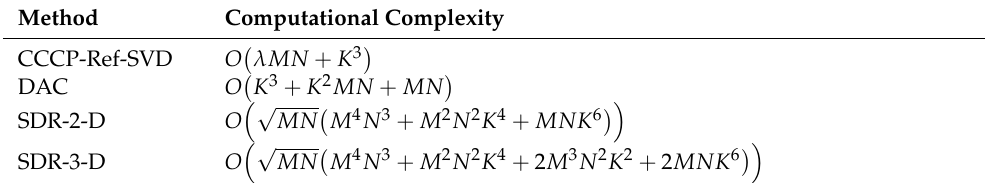
Table 1. Comparison of the computational